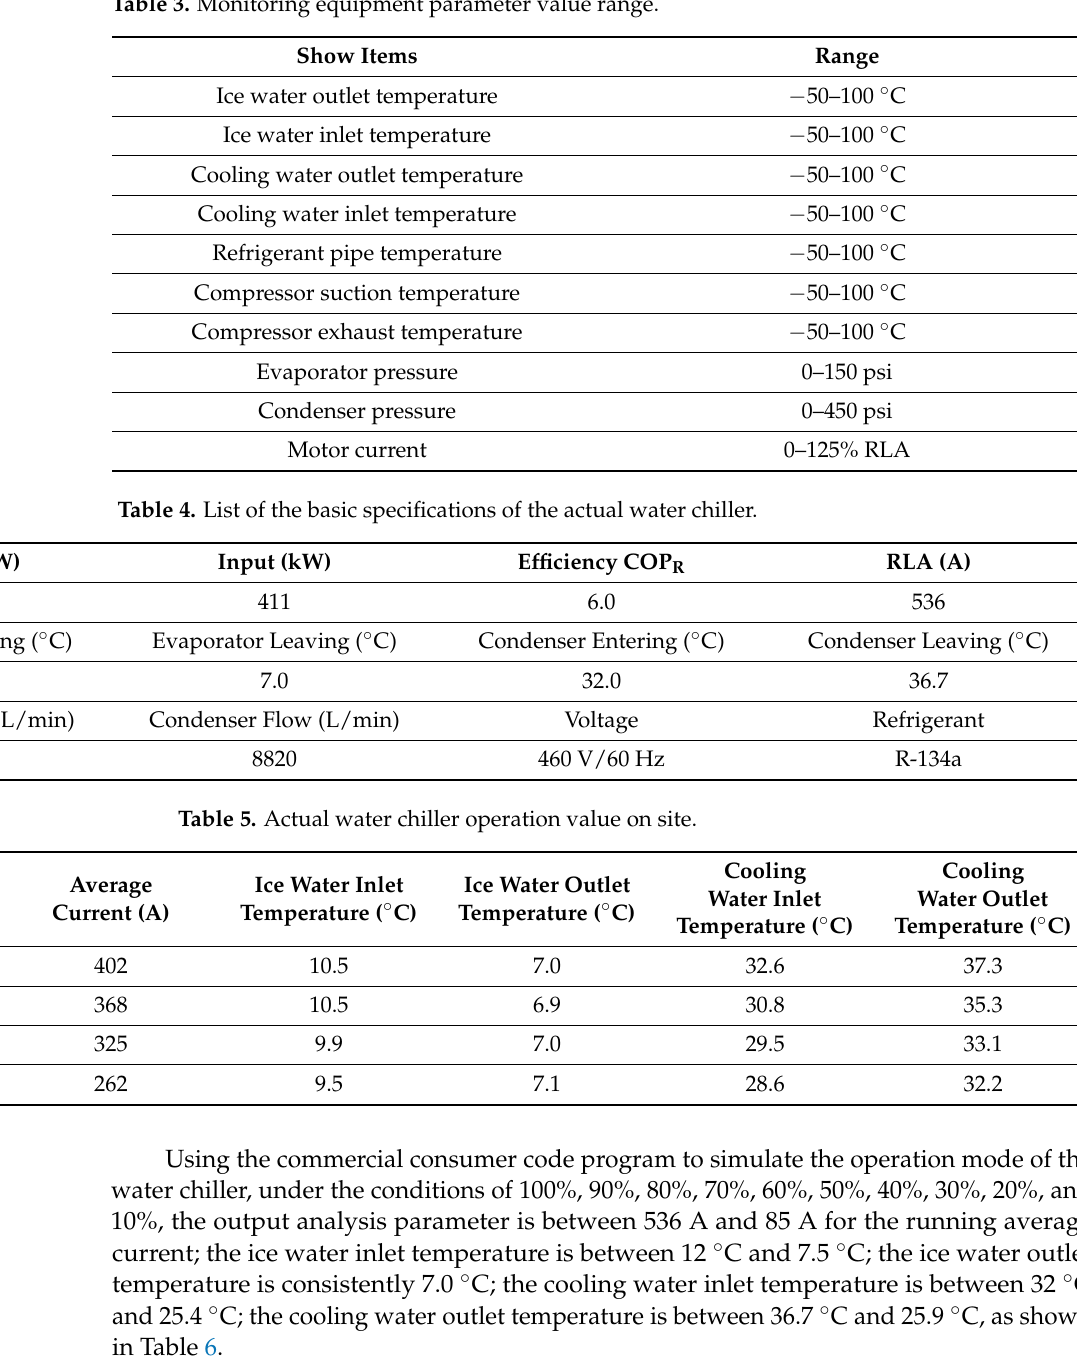
Table 3. Monitoring equipment parameter value range.